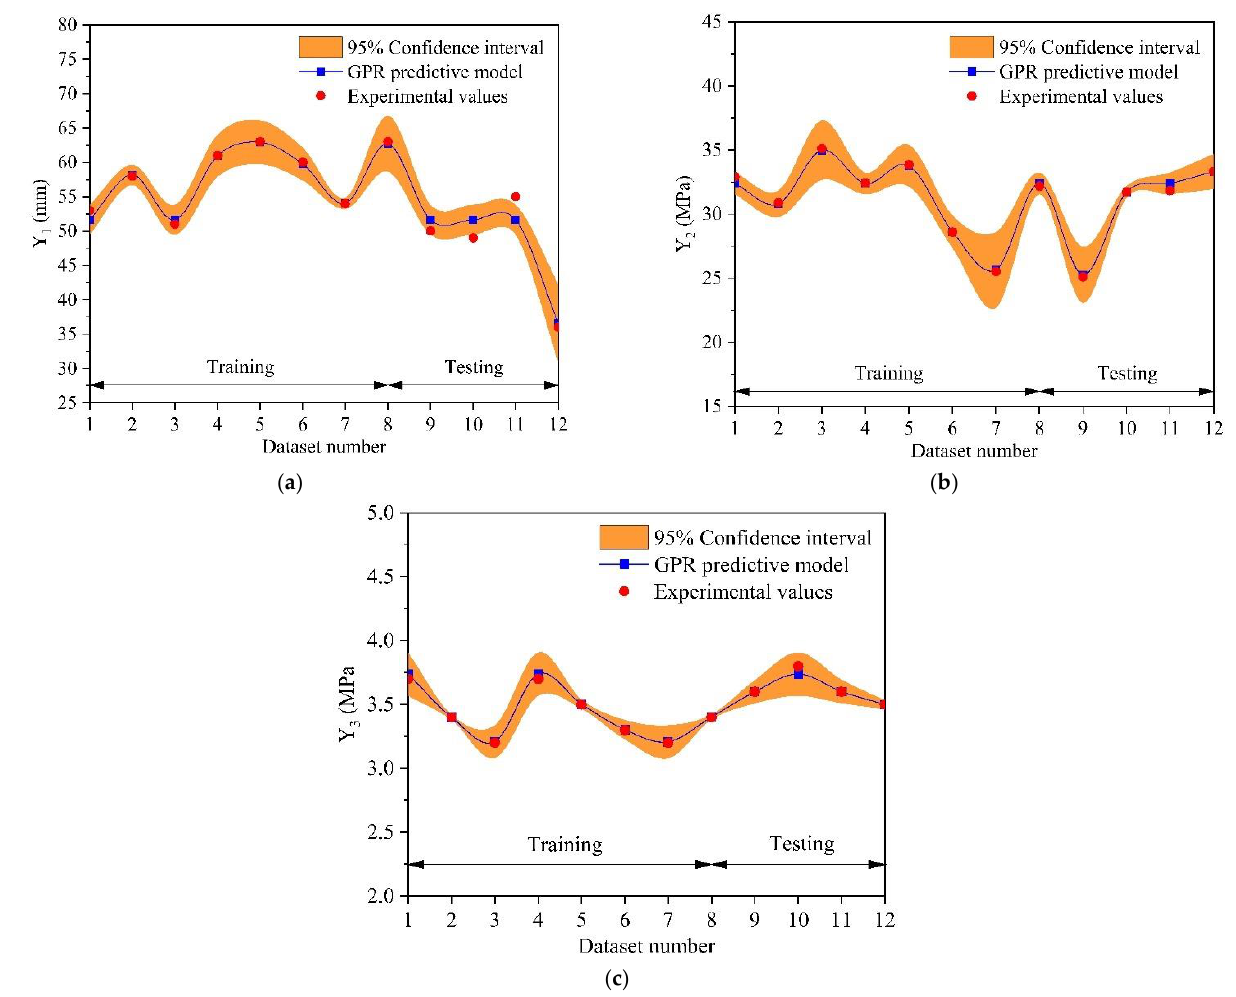
Figure 12. Comparison of the predictive values by GPR versus the experimental values: ( a ) Y 1 ; ( b ) Y 2 ; and ( c ) Y 3 .